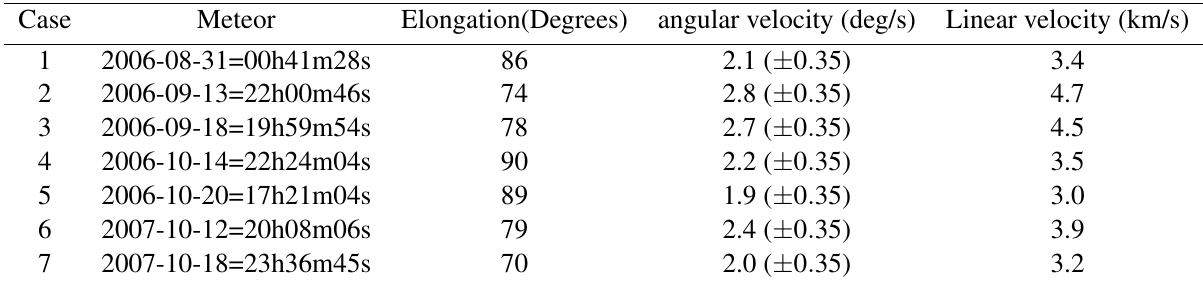
Table 1 Characteristics of meteors from space